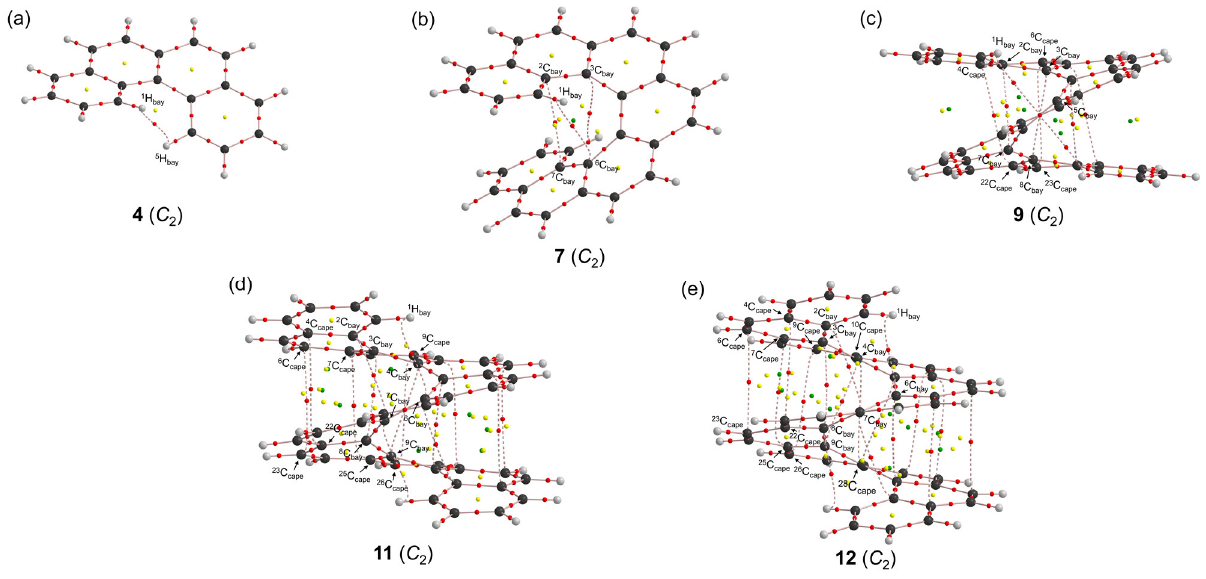
Figure 2. Molecular graphs for 4 ( a ), 7 ( b ), 9 ( c ), 11 ( d ), and 12 ( e ), calculated with M06-2X/6- 311+G(3d,p), where BPs with BCPs corresponding to intramolecular noncovalent interactions are detected. The BCPs are denoted by red dots, RCPs (ring critical points) by yellow dots, CCPs (cage critical points) by green dots, and BPs by pink lines. The carbon atoms are in black and the hydrogen atoms are in grey.